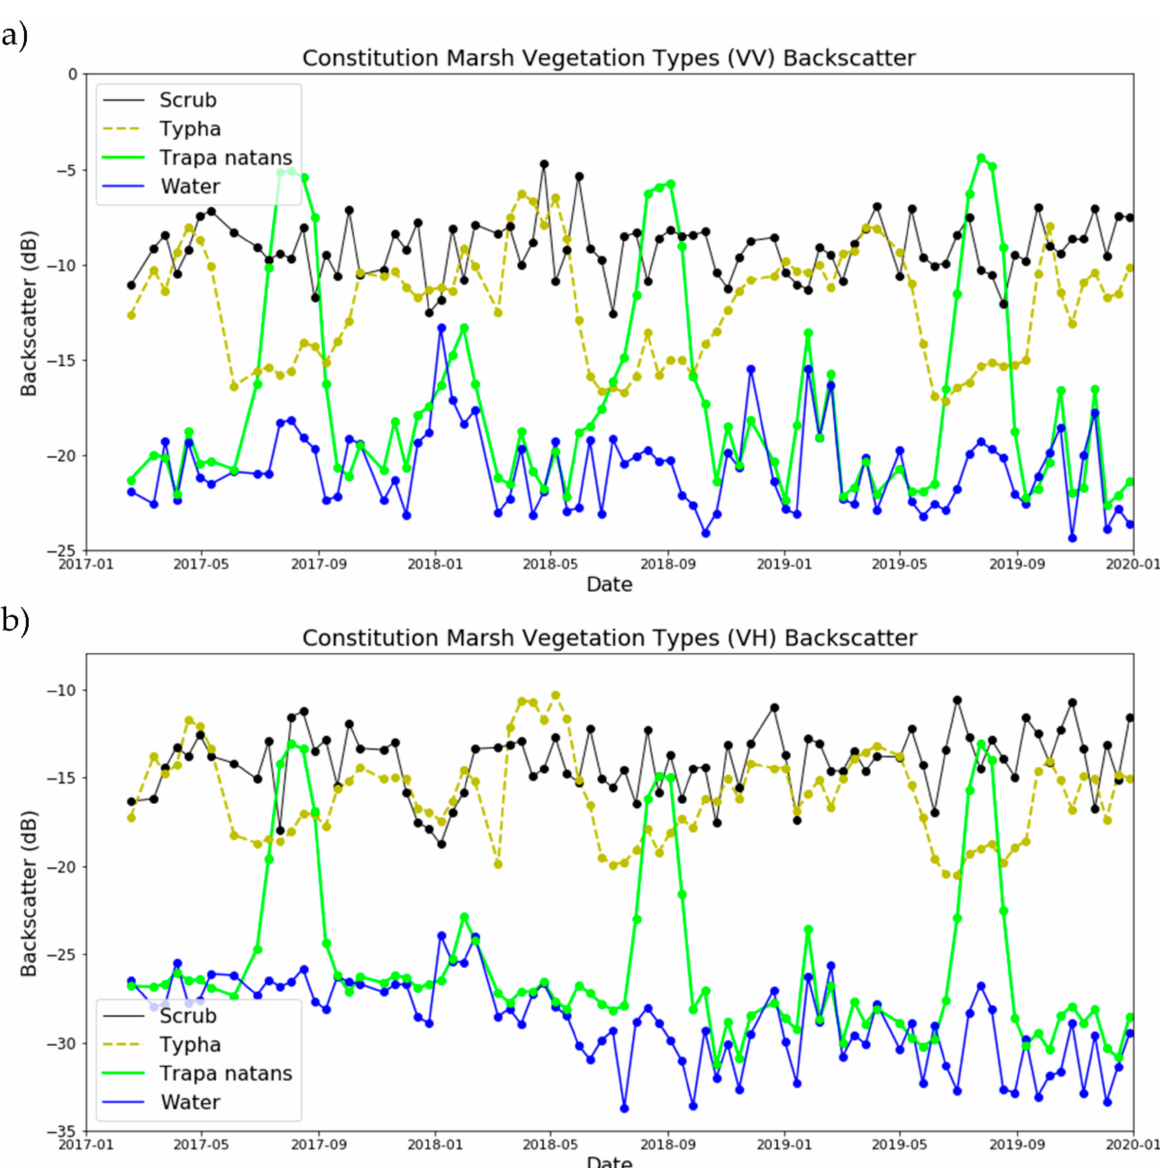
Figure 8. Constitution Marsh Sentinel-1 VV and VH polarized backscatter time-series from 2017–2019 (panels ( a ) and ( b ), respectively). Dates are shown in numeric year-month format. The wetlands and deepwater classes are as follows: solid black series = shrub-scrub, dashed gold series = Typha spp., solid green series = Trapa natans , solid blue = open